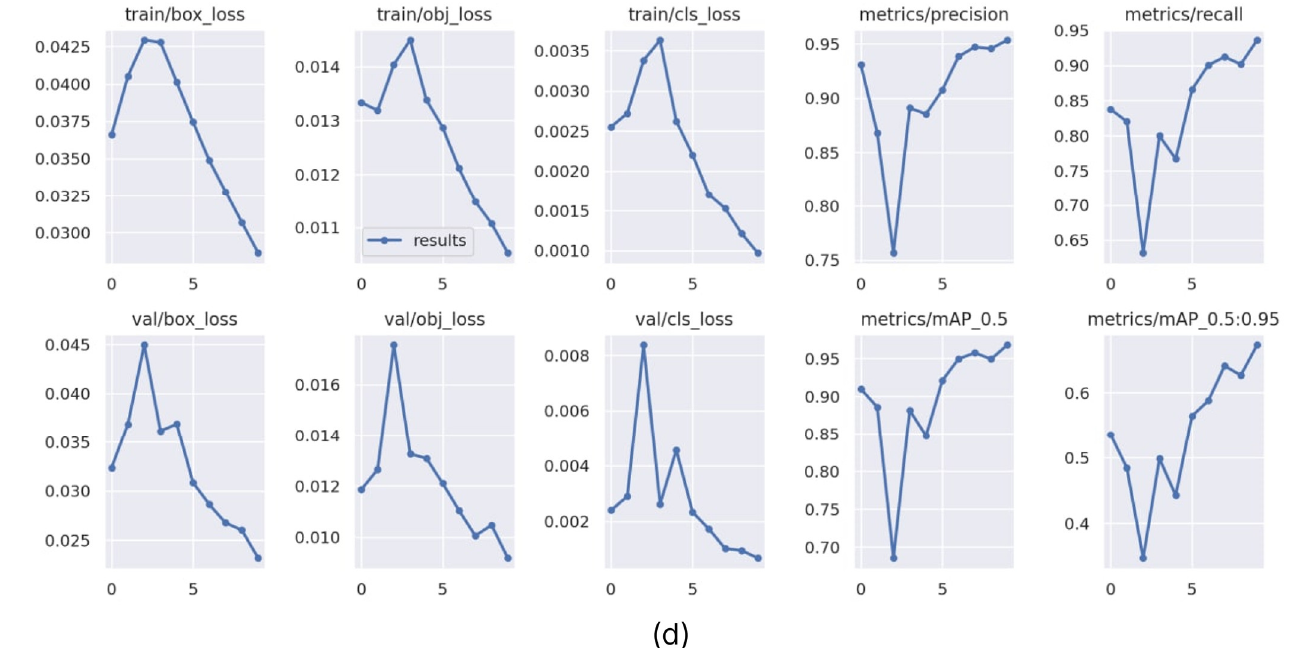
Figure 10. Second case model training and validation metrics for a set of counter images. ( a ) Correlogram of ROI labels; ( b ) Distribution density of image labeling parameters; ( c ) Confusion matrix; ( d ) Standard set YOLOv5 training and validation metrics.